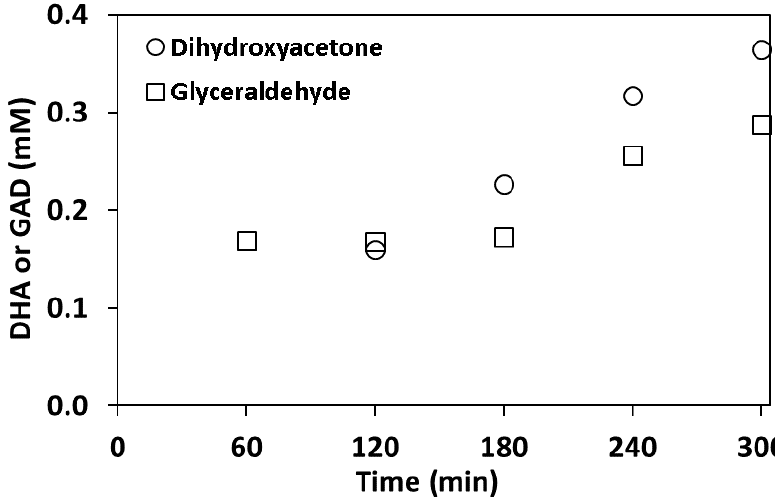
Figure 3. Photocatalytic reaction of glycerol in water under simulated solar light. The concentration of DHA and GAD in the water phase over time. Water: 100 mL, glycerol: 4 mmol, Degussa P25 TiO 2 : 1 g.